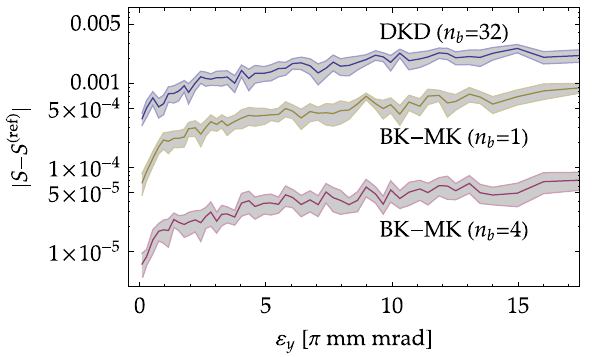
FIG. 15. Amplitude dependence of the single-turn spin errors for three different integrators: drift-kick with n and BK/MK with n